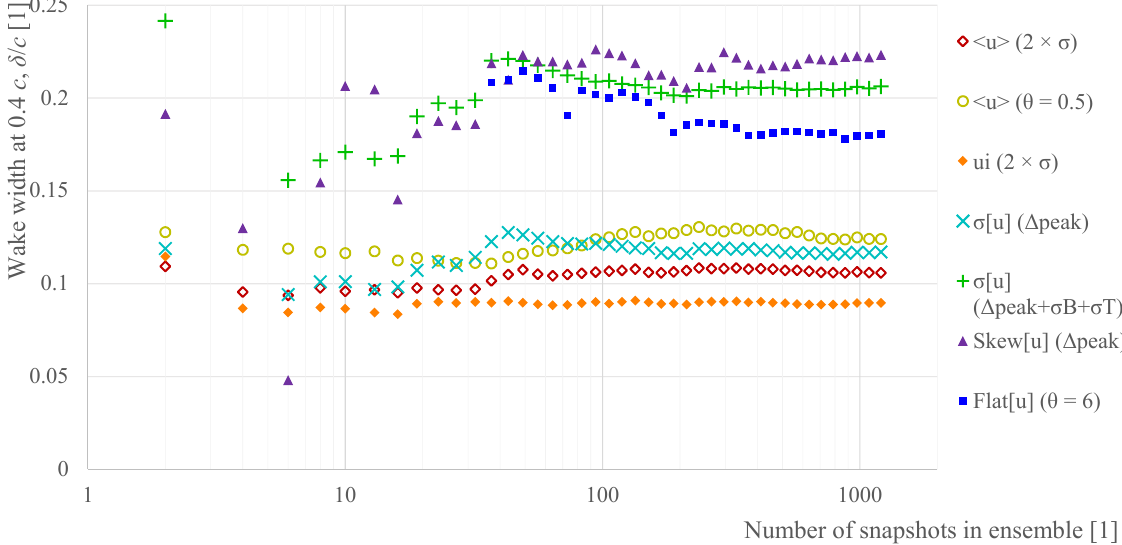
Figure 16. Wake widths at constant distance x / c = 0.4 as a function of number of snapshots used for averaging.